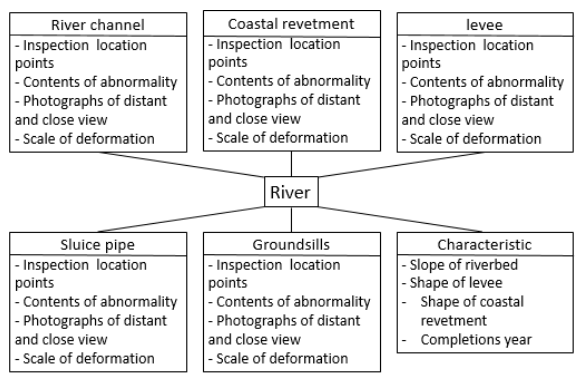
Figure 9. Information accumulated in the system